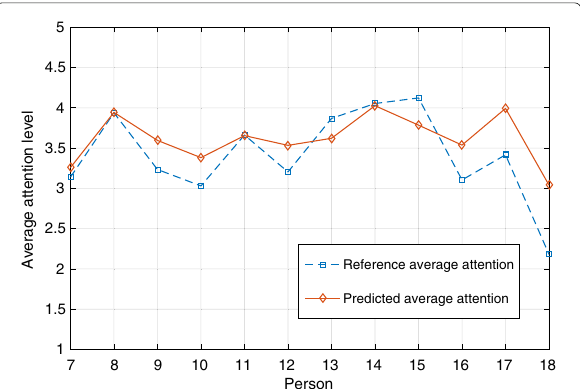
Fig. 7 Average attention of subjects. The blue boxes represent average attention of the test subjects calculated from human observations, while red diamonds represent estimated average attention of subjects by the best attention classifier (bagged